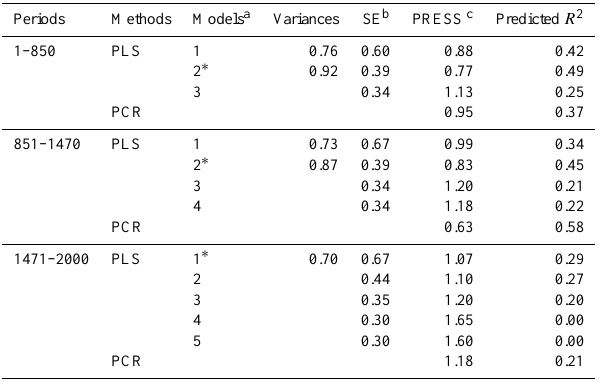
Table 2. Selected number of components from the PLS regression and the first two components from the PCR between proxies and observations. Verifications are based on the leave-one-out cross- validation